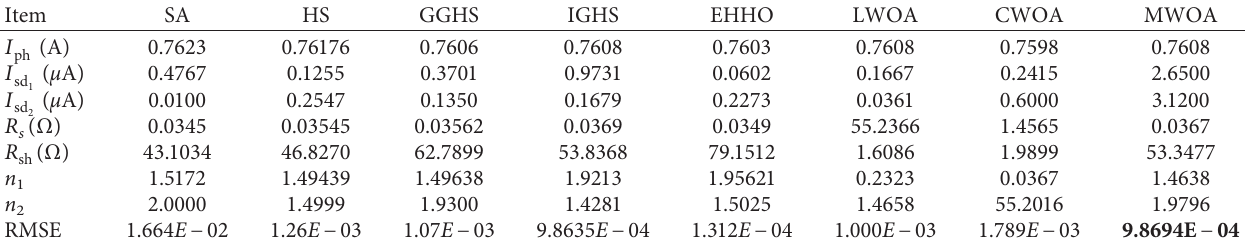
Table 4: Identification results of DDM based on seven algorithms.